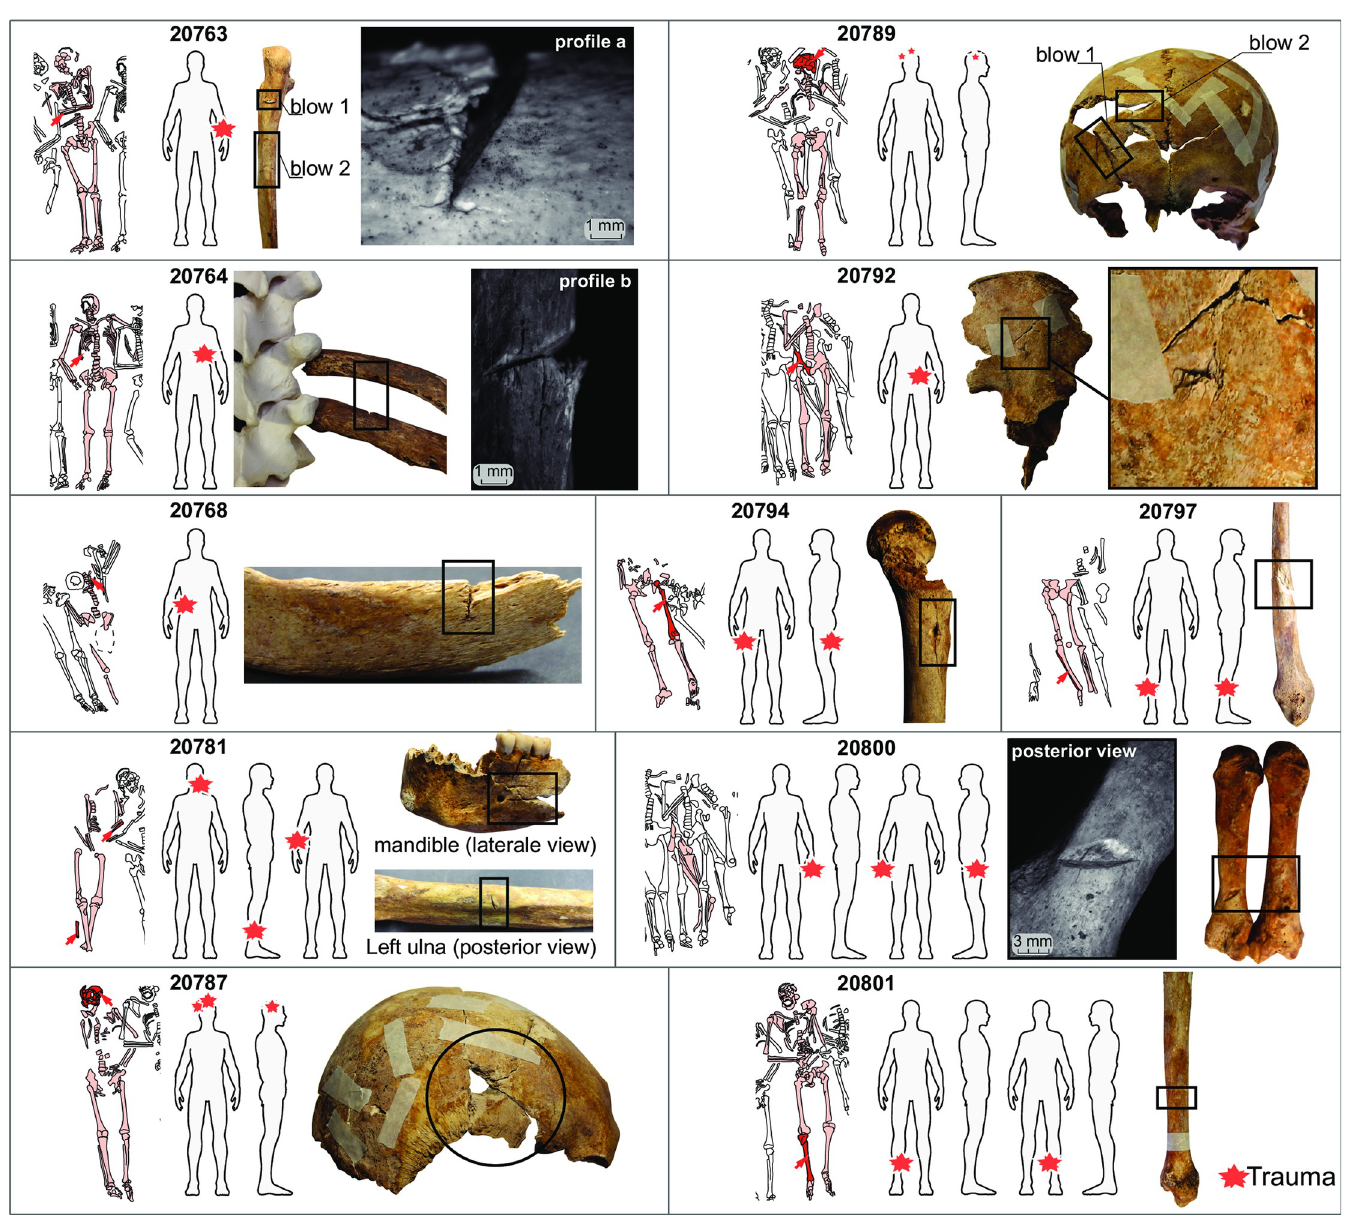
Fig 3. Lesions and paleopathological data for individuals recovered from Gr. 337. Each box represents one individual characterized by its numeric ID (S8 Fig in S1 File). The skeleton schematics represent the reconstructed in situ grave position. Red stars on gray body shape point to the location of traumatic injuries. Black circles and rectangles indicate macroscopic observations of traumatic injuries on bones and selected epifluorescence macroscope photos (profile a, b and posterior view, S6 Fig in S1 File). See supplementary information for a better observation of the lesions.